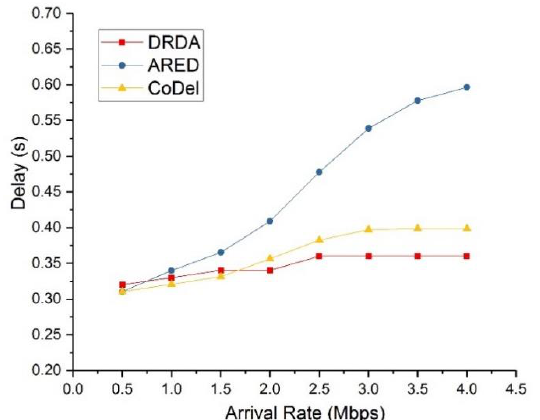
Figure 7. End-to-end delay of DRDA compared with that of ARED and CoDel.